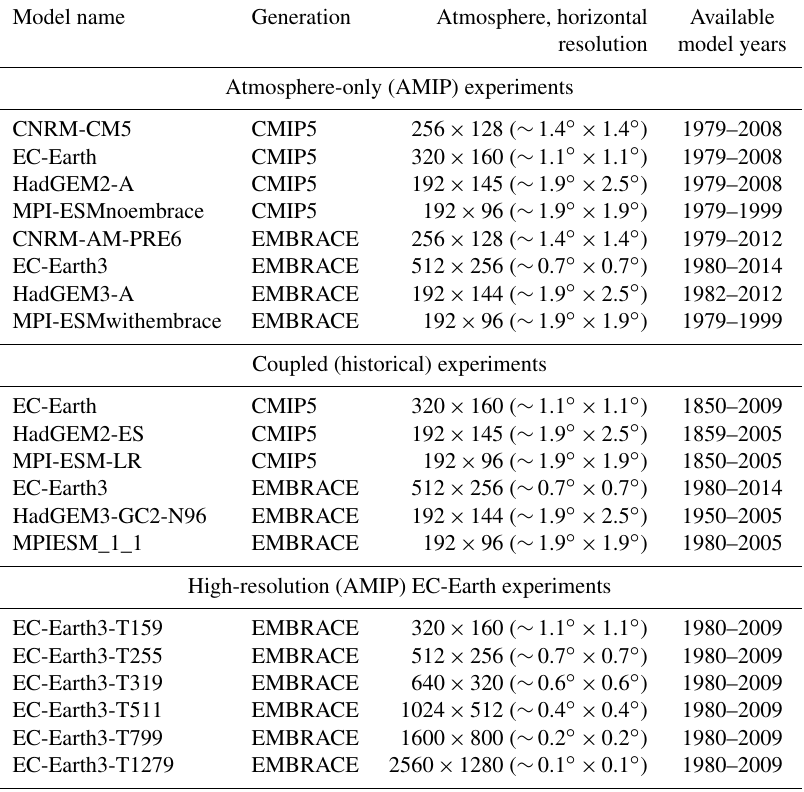
Table 2. List of model configurations and model experiments analyzed. If more than one ensemble member is available, only the first ensemble “r1i1p1” is